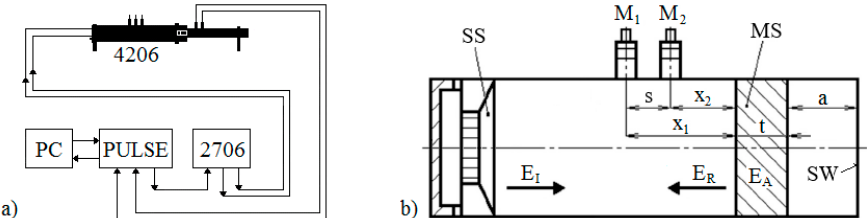
Figure 3. Circuit diagram of the experimental equipment for measuring the sound reflection coef- ficient ( a ) and a schematic of the acoustic impedance tube ( b ). Legend to the abbreviations: a —air gap size; E A —absorbed sound energy; E I —incident sound energy; E R —reflected sound energy; M 1 , M 2 —measuring microphones; MS—measured specimen; s —distance between microphones M 1 and M 2 ; SS—sound source; SW—solid wall; t —sample thickness; x 1 , x 2 —microphone distances from the tested PLA sample surface.